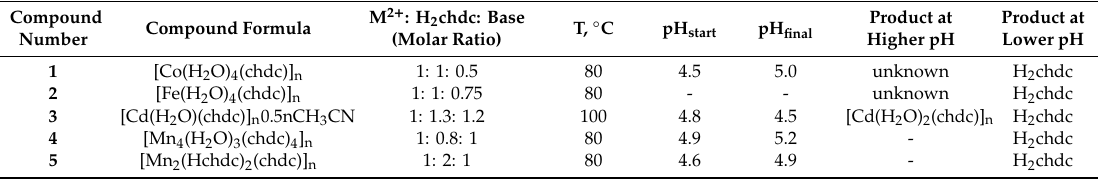
Table 1. Synthetic details for 1 – 5